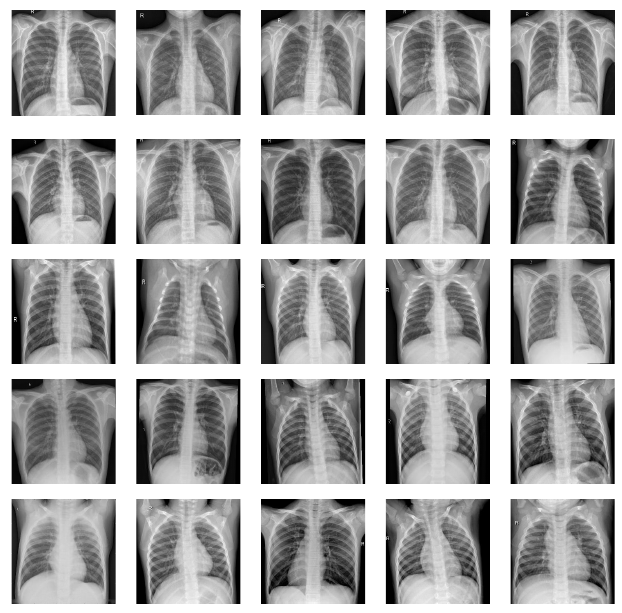
Figure 3. Some images of the normal